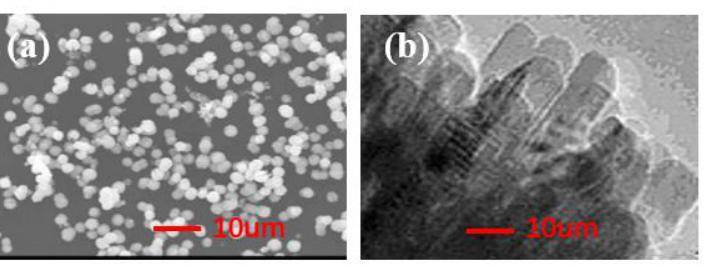
Figure 1. SEM characterization of TiO 2 -bulk ( a ) and TiO 2 -rod ( b ).